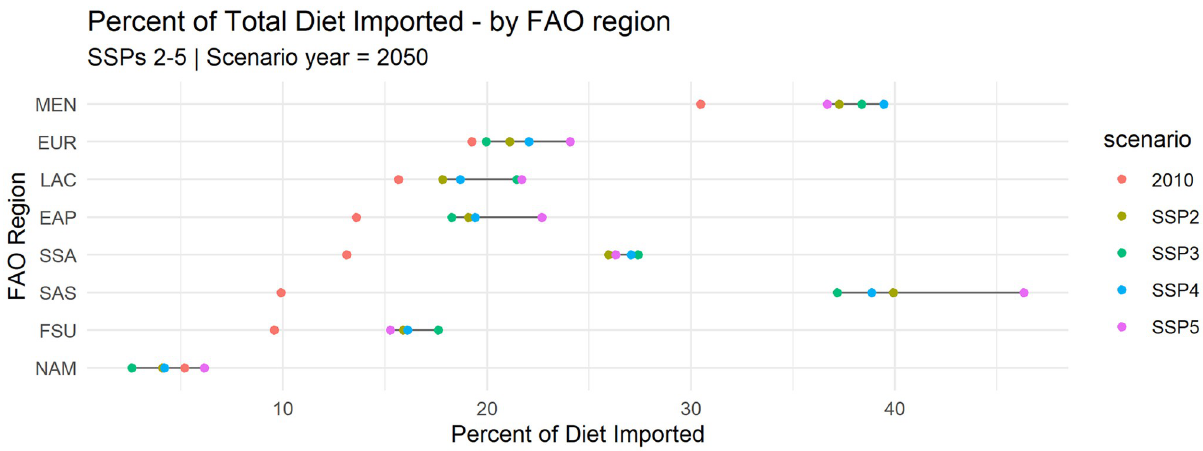
Fig 3. 2050 projected average “distance” (overshoot or undershoot) from ideal diet (zero = ideal). Regional averages are a population-weighted average of country-level overshoot/undershoot as projected by the IMPACT model. Regions as follows: SSA = Sub-Saharan Africa, SAS = South Asian States, NAM = North America, MEN = Middle East/North Africa, LAC = Latin America and Caribbean, FSU = Former Soviet Union, EUR = Europe, EAP = East Asia Pacific.